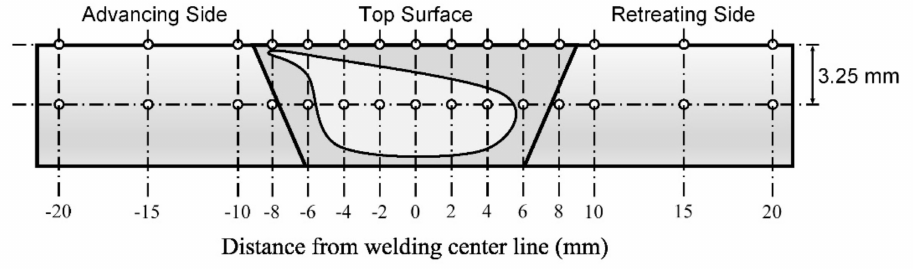
Figure 10. Position for measuring